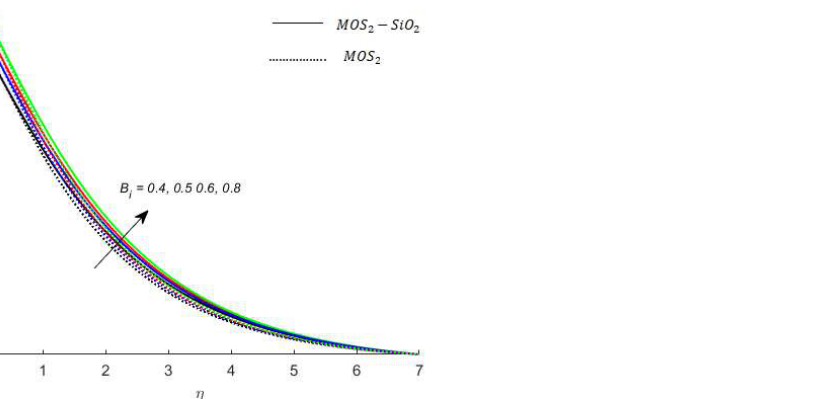
Figure 11. Variation in temperature for 𝐵 (cid:3036) when 𝑀 = 0.2,𝑃𝑟 = 2.36,𝑆𝑟 = 0.1,𝑆𝑐 = 0.8, (𝐺𝑟) (cid:3030) = 0.1,𝐾 = 0.1,and 𝛽 ∗ = 0.1 .